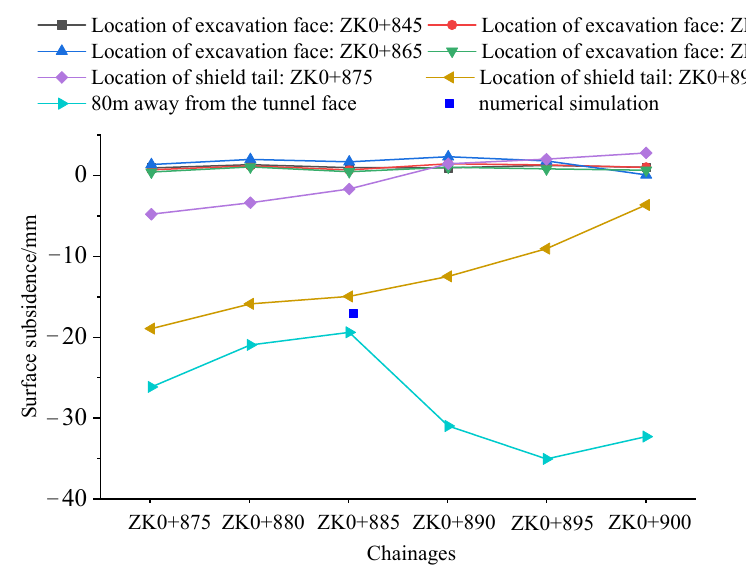
Figure 13. Surface settlements of different chainages.